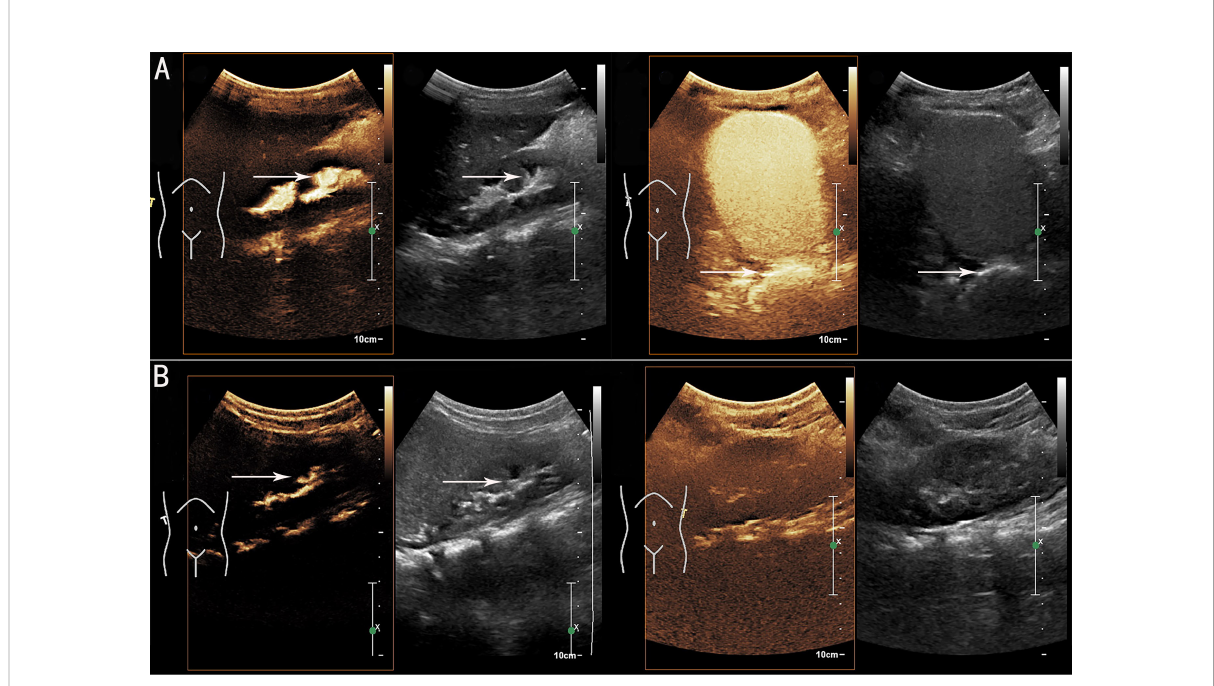
Relevant clinical features, investigations and treatment